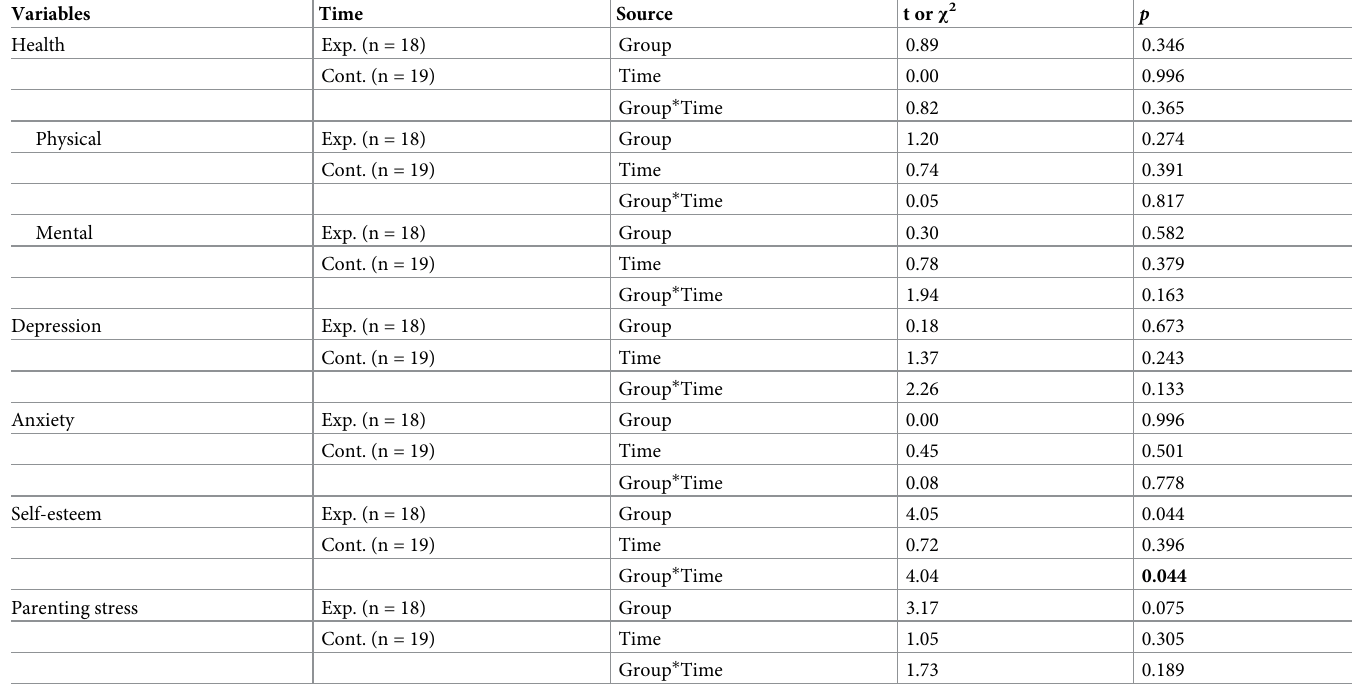
Table 4. Results of the generalized estimating equation model for outcome variables (N = 37).